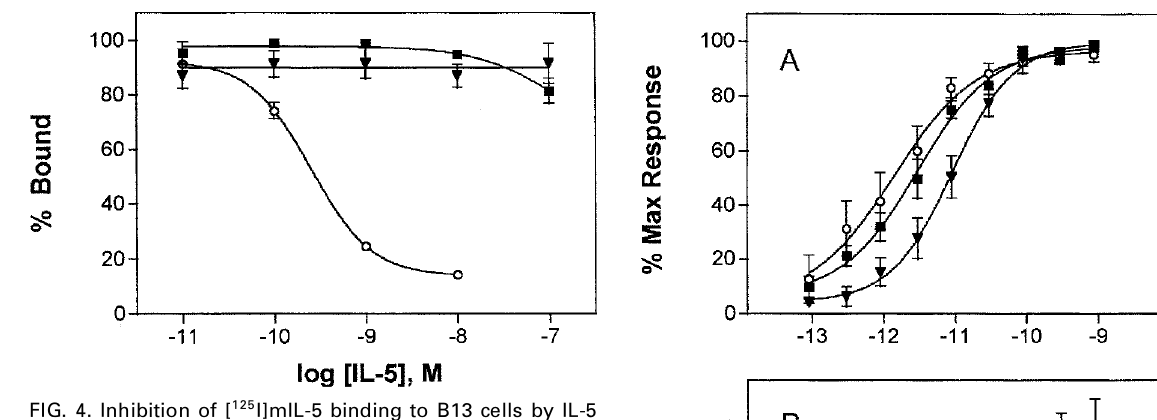
FIG. 4. Inhibition of [ 125 I]mIL-5 binding to B13 cells by IL-5 orthologs. Cells were incubated with 50pM [ 125 I]mIL-5 in the presence of various concentrations of gpIL-5 ( . ), hIL-5 ( j ), or mIL-5 ( s ). After 60min, cells were centrifuged through an oil layer to separate bound from free ligand and the cell pellet processed as described in Methods. Data are expressed as percent of control binding and represent the mean±SEM from three experiments performed in triplicate.